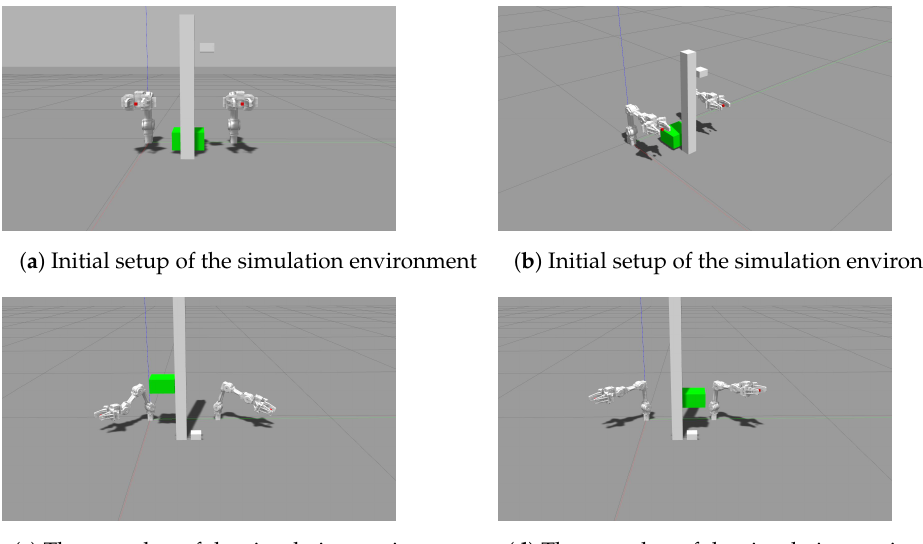
Figure 5. The GAZEBO